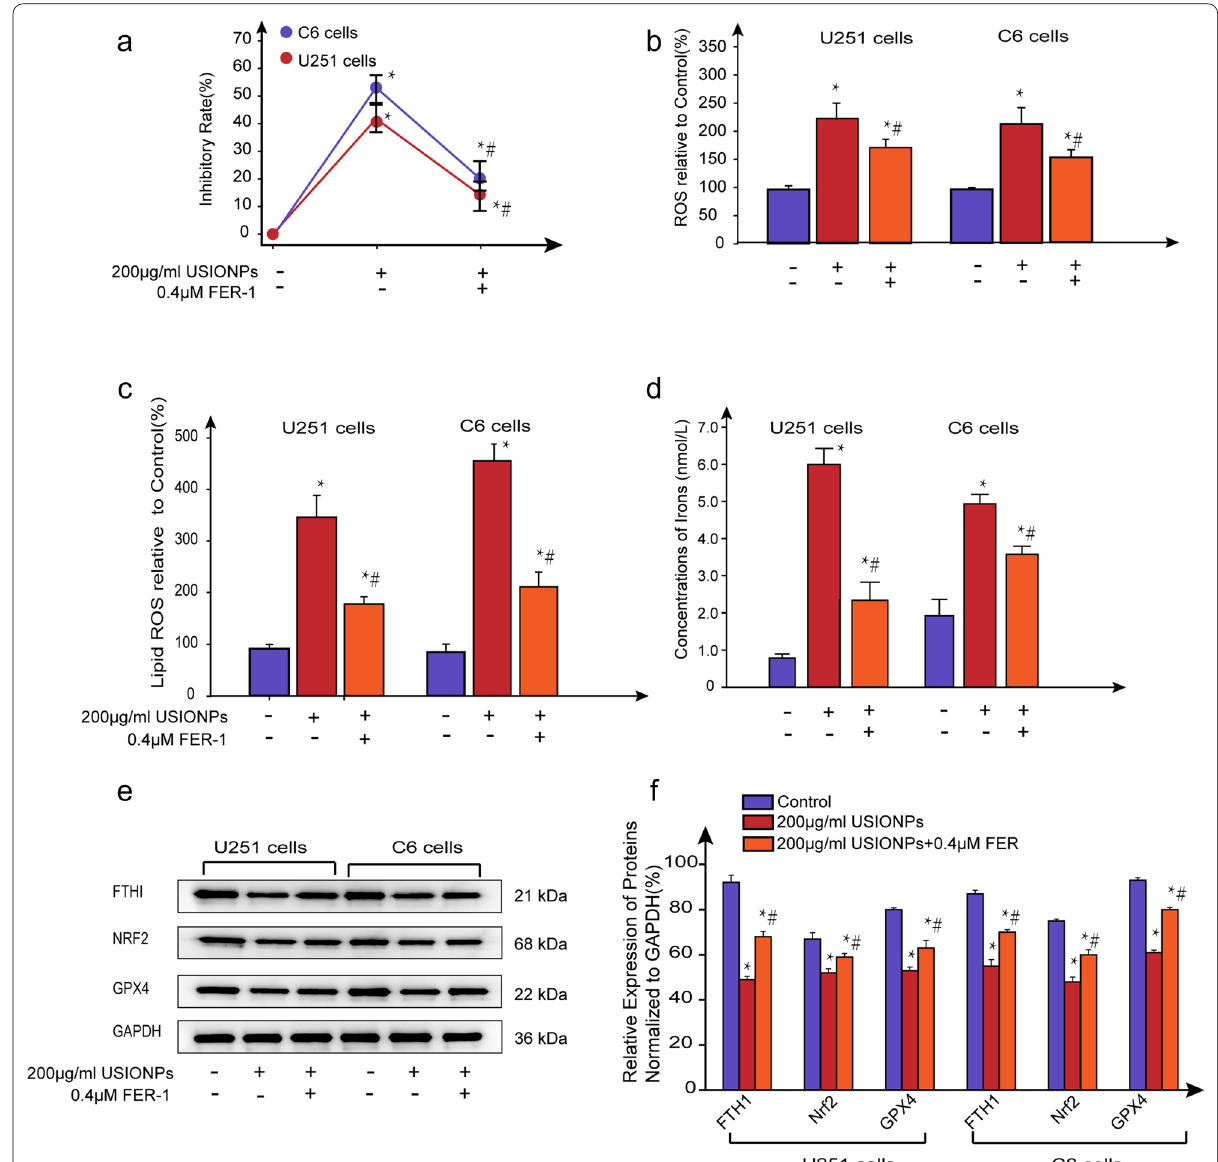
Fig. 4 USIONPs-induced ferroptosis reversed by FER-1. a Inhibitory rates of U251 cells and C6 cells in exposure to USIONPs with or without 0.4 μmol/L FER-1 for 48 h; b Relative levels of ROS in the U251 cells and C6 cells in exposure to USIONPs with or without 0.4 μmol/L FER-1 for 48 h; c Relative levels of lipid ROS in the U251 cells and C6 cells in exposure to USIONPs with or without 0.4 μmol/L FER-1 for 48 h; d Concentrations of iron in the U251 cells and C6 cells in exposure to USIONPs with or without 0.4 μmol/L FER-1 for 48 h; E Representative images of ferroptosis related proteins in the U251 cells and C6 cells in exposure to USIONPs with or without 0.4 μmol/L FER-1 for 48 h; f Relative expression levels of proteins involved in the ferroptosis pathway in the U251 cells and C6 cells in exposure to USIONPs with or without 0.4 μmol/L FER-1 for 48 h. * P < 0.05, statistically significant compared with control group. # P < 0.05, statistically significant compared with 200 μg/mL